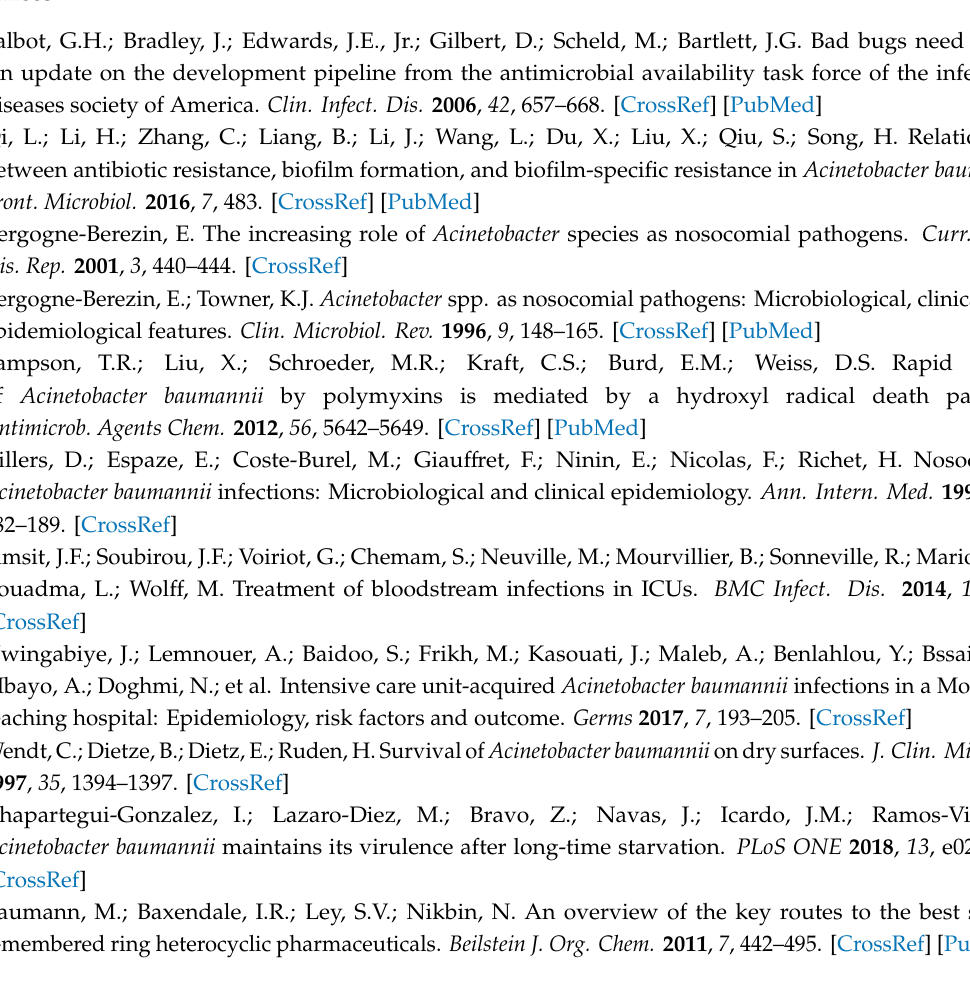
Figure S1: Rapid killing of A. baumannii ATCC 17978 by halogenated indoles, Figure S2: Biofilm inhibition of A. baumannii by 6-iodoindole, Figure S3: Additional confocal microscopic images showing biofilm inhibition of A. baumannii , Figure S4: Additional SEM images showing membrane damage by 5-iodoindole in A. baumannii cells Table S1: Determination of minimum inhibitory concentrations (MICs) of 5-iodoindole for A. baumannii ATCC 17978 and clinical isolates. MIC determinations after culture for 24 h at 37 ◦ C in 96-well plates in the presence of 5-iodoindole, Table S2: MICs of halogenated indole derivatives against A. baumannii ATCC 17978, Table S3: Antibiofilm and antibacterial activities of indole compounds against A. baumannii ATCC